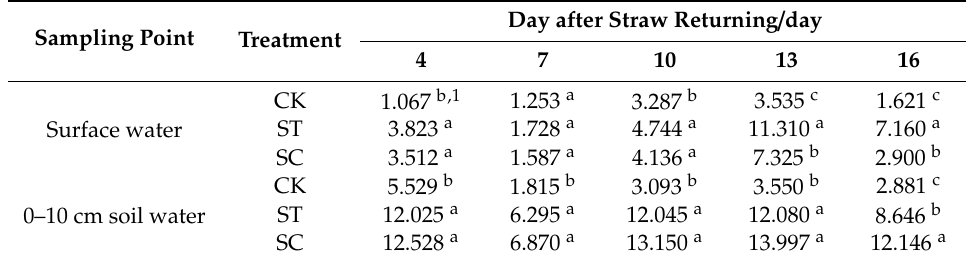
Table 2. NO 3 − -N concentration of di ff erent treatments.